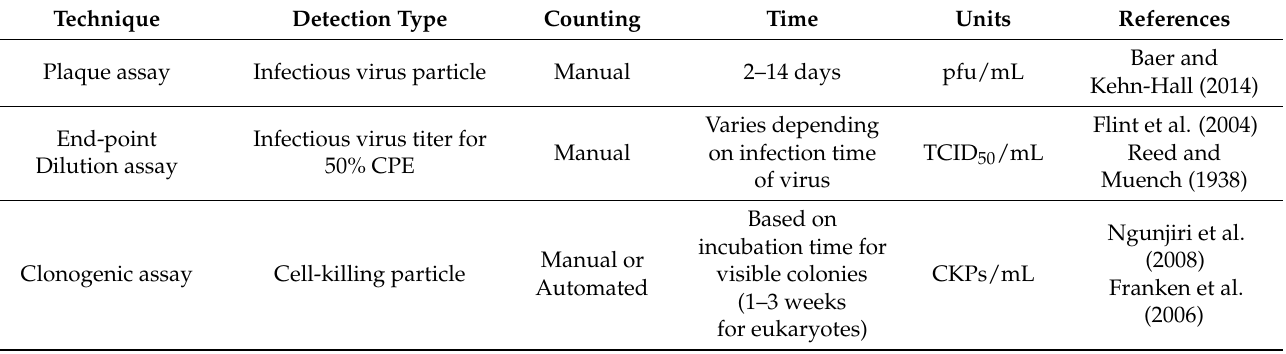
Table 2. Virus particle quantification techniques based on biological functions and